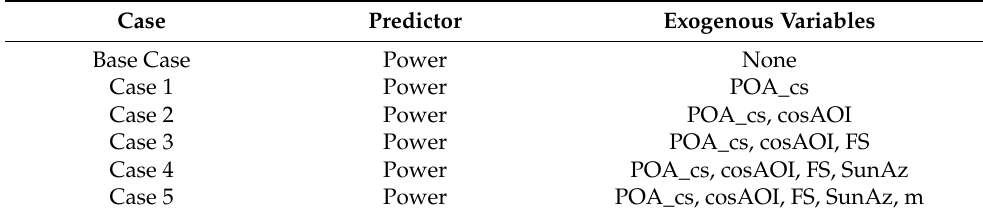
Table 1. Case matrix for exploring the role of exogenous